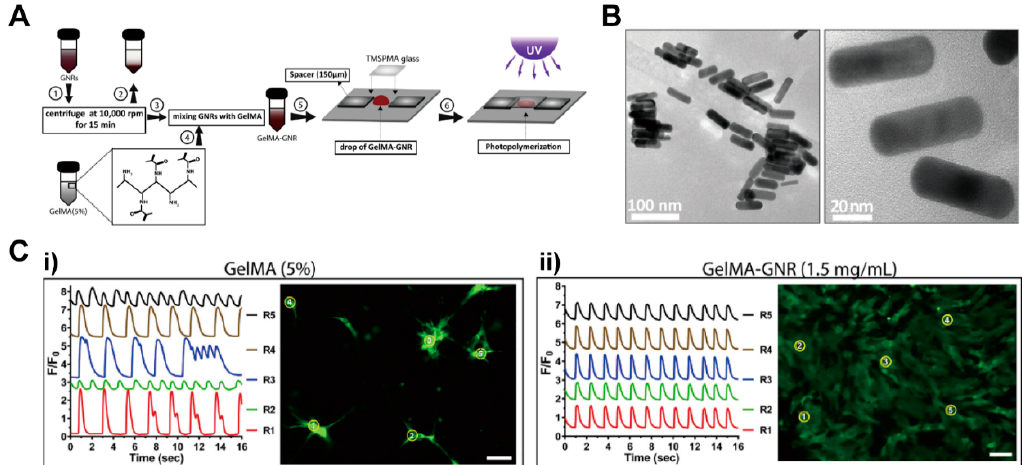
Figure 14. ( A ) Fabrication of gelatin methacrylate (GelMA)-gold nanorod (GNR) hybrid hydrogels and transmission electron microscopy (TEM) image of GNRs ( B ). ( C ) Calcium transient signals by measurement of intensity within cultured cardiomyocyte for (i) GelMA (5%) and (ii) GelMA-GNR (1.5 mg/mL). Scale bar: 100 μ m for ( C ). Reprinted from [102]. Copyright (2016) Elsevier. (1.5 mg / mL). Scale bar: 100 µ m for ( C ). Reprinted from [102]. Copyright (2016)